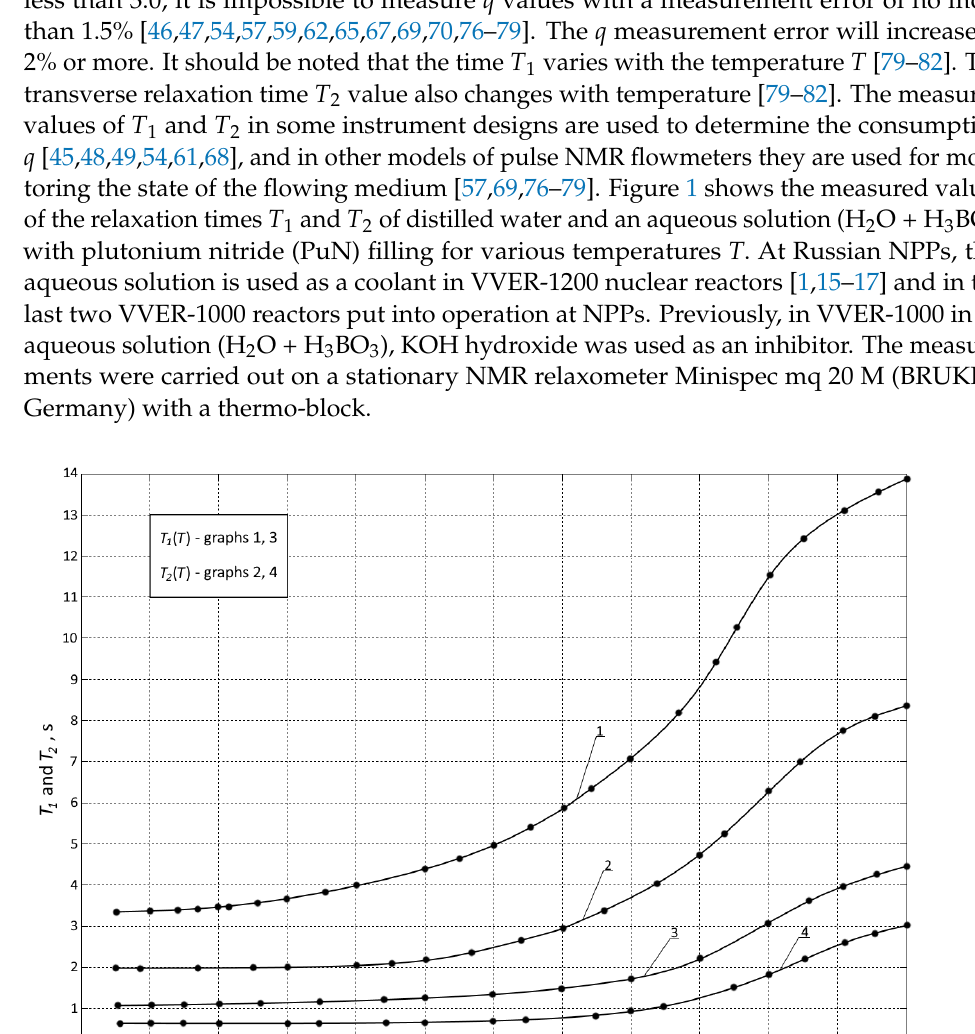
Figure 2. Extrapolation of the change in the values of the longitudinal Т 1 and transverse Т 2 relaxation times from the temperature Т of an aq ueous solution (Н 2 O + Н 3 СО 3 ) with plutonium nitride filling. Graph 1 corresponds to the change in the value of T 1 , graph 2- T 2 . As a result, we determined the values of Т 1 = 20.23 ± 1.02 s and Т 2 = 15.54 ± 0.76 s for T = 960 K. Such data on the relaxation times of an aqueous solution (H 2 O + H 3 BO 3 ) with plutonium nitride filling were obtained for the first time in the world. To satisfy the con- dition listed in Equation (2), the time t p must be at least 61 s. The obtained results show that the previously developed designs of pulse NMR flowmeters [60 – 69,78] for small pipe diameters (no more than 40 mm) and low flow rates of liquids at temperatures below 320 K are challenging to apply. The use of small-size magnetic assemblies of the Halbach- Array type for magnetizing the flowing liquid [57,58,60,61,68] is excluded. It will be ex- tremely difficult to fulfill condition (2) with their use. Another problem associated with the residence time of a liquid segment in the re- cording coils of a pulsed NMR flowmeter for measuring the consumption q and relaxation times T 1 and T 2 cannot be solved under current operating conditions in nuclear reactors. This is because particular sequences of pulses and time intervals for the repetitions are